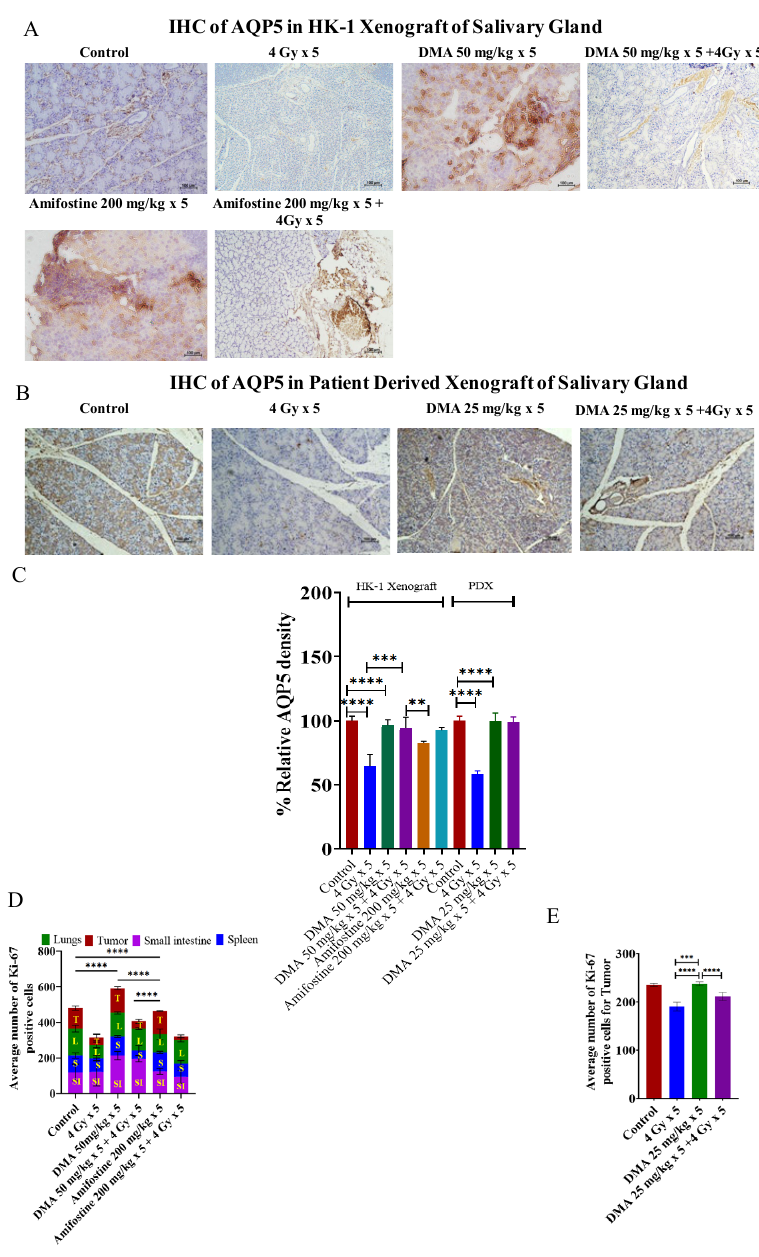
Figure 5. Expression of AQP5 in the salivary gland of xenograft models. Representative images depicting immunostaining for AQP5 in ( A ) HK-1 xenograft and ( B ) PDX salivary gland sections; images are representative of three tissue samples. Scale bar = 100 µ m. Bar graphs showing the immunostaining quantification of ( C ) AQP5 for HK-1 and PDX mouse models; the average number of Ki-67-positive cells for the quantification of ( D ) HK-1 and ( E ) PDX models was performed using15 random histological slides. The brown color represents the positive staining of AQP5 with blue counterstaining. p -values at ** < 0.005. *** < 0.0005 and **** < 0.00005 indicate statistical